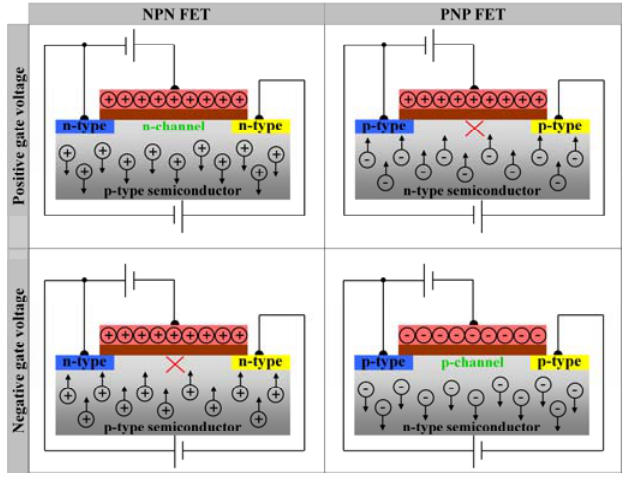
Figure 14. Schematic diagram of the varying source-drain current density as a function of semiconductor type and gate voltage. Top left: Applying a positive gate voltage to a n- channel FET (NPN FET) will create a conductive channel from source to drain. Bottom left: Applying a negative gate voltage to a n-channel FET (NPN FET) will block current flow between source and drain. Top right: Applying a positive gate voltage to a p-channel FET (PNP FET) will block current flow between source and drain. Bottom right: Applying a negative gate voltage to a p-channel FET (PNP FET) will create a conductive channel from source to